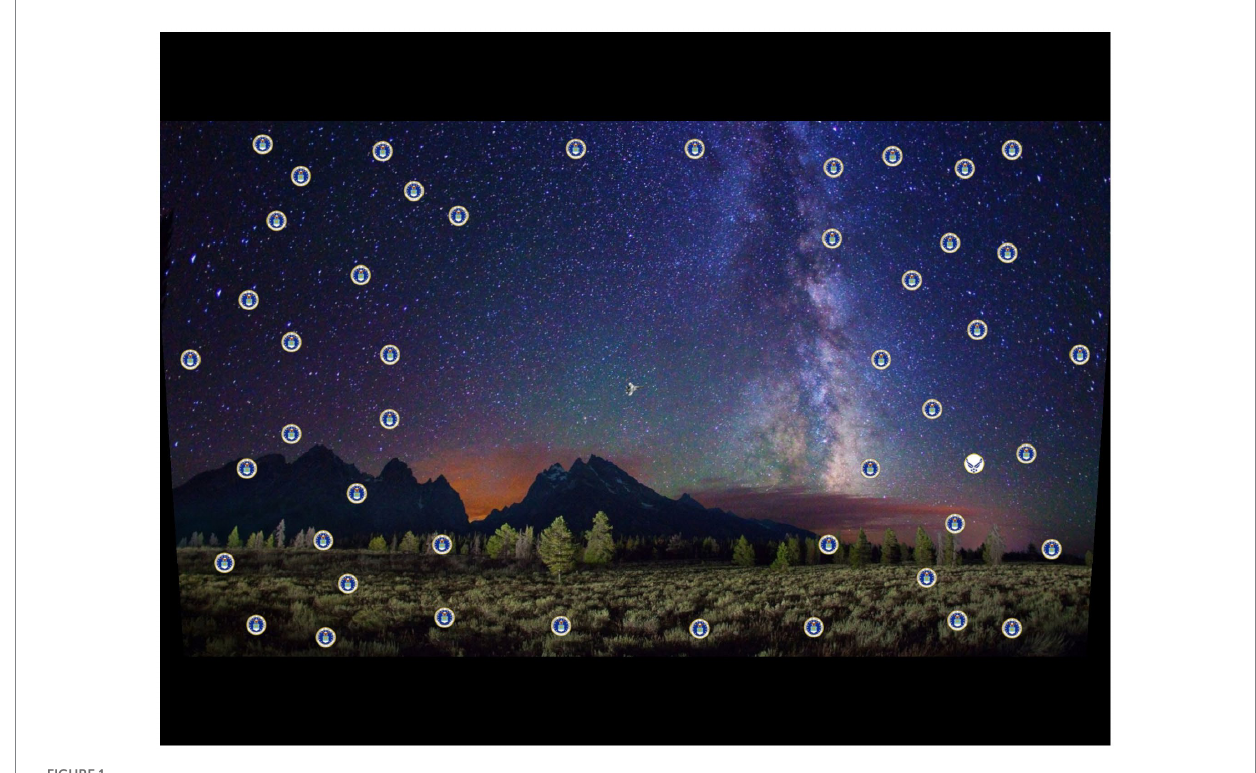
FIGURE 1 Visual scene shown to the participant. Adapted with permission from USAFRL.